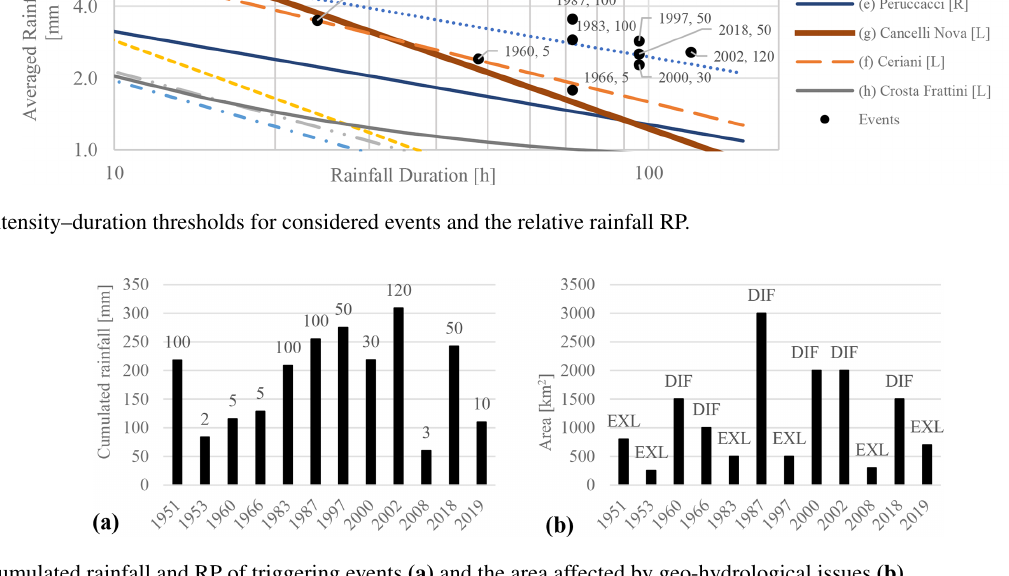
Figure 6. Cumulated rainfall and RP of triggering events (a) and the area affected by geo-hydrological issues (b)